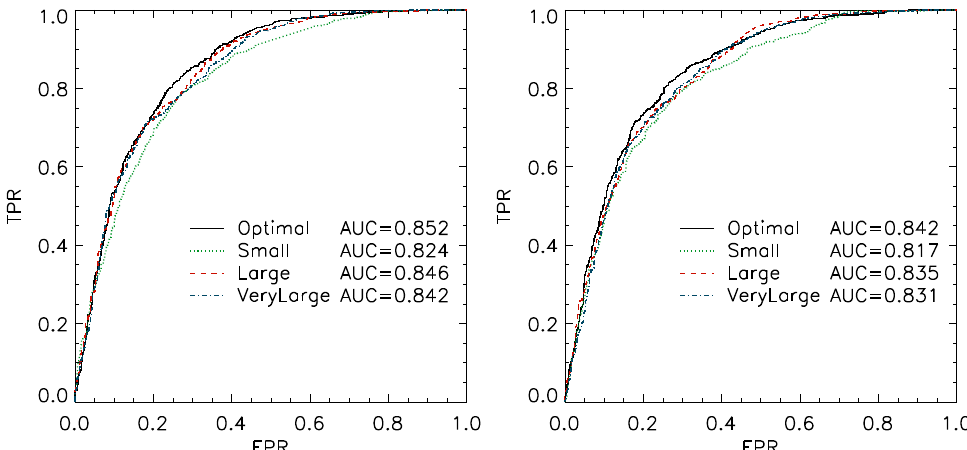
Figure 1. The ROC curves for various MLP architectures. FPR is the false positive rate and TPR is the true positive rate. The ‘Optimal’ size MLP model consists of 17 × 35 × 35 × 1 network architecture, i.e., the input layer consists of 17 neurons, the finally output layer consists of 1 neuron, and 2 intermediate hidden layers consist of 35 neurons each. ‘Small’, ‘Large’, and ‘VeryLarge’ models comprise 17 × 3 × 1, 17 × 100 × 100 × 100 × 1, and 17 × 100 × 100 × 100 × 100 × 1, respectively. The left and right panels show, the best and the median models out of all 50 trials,